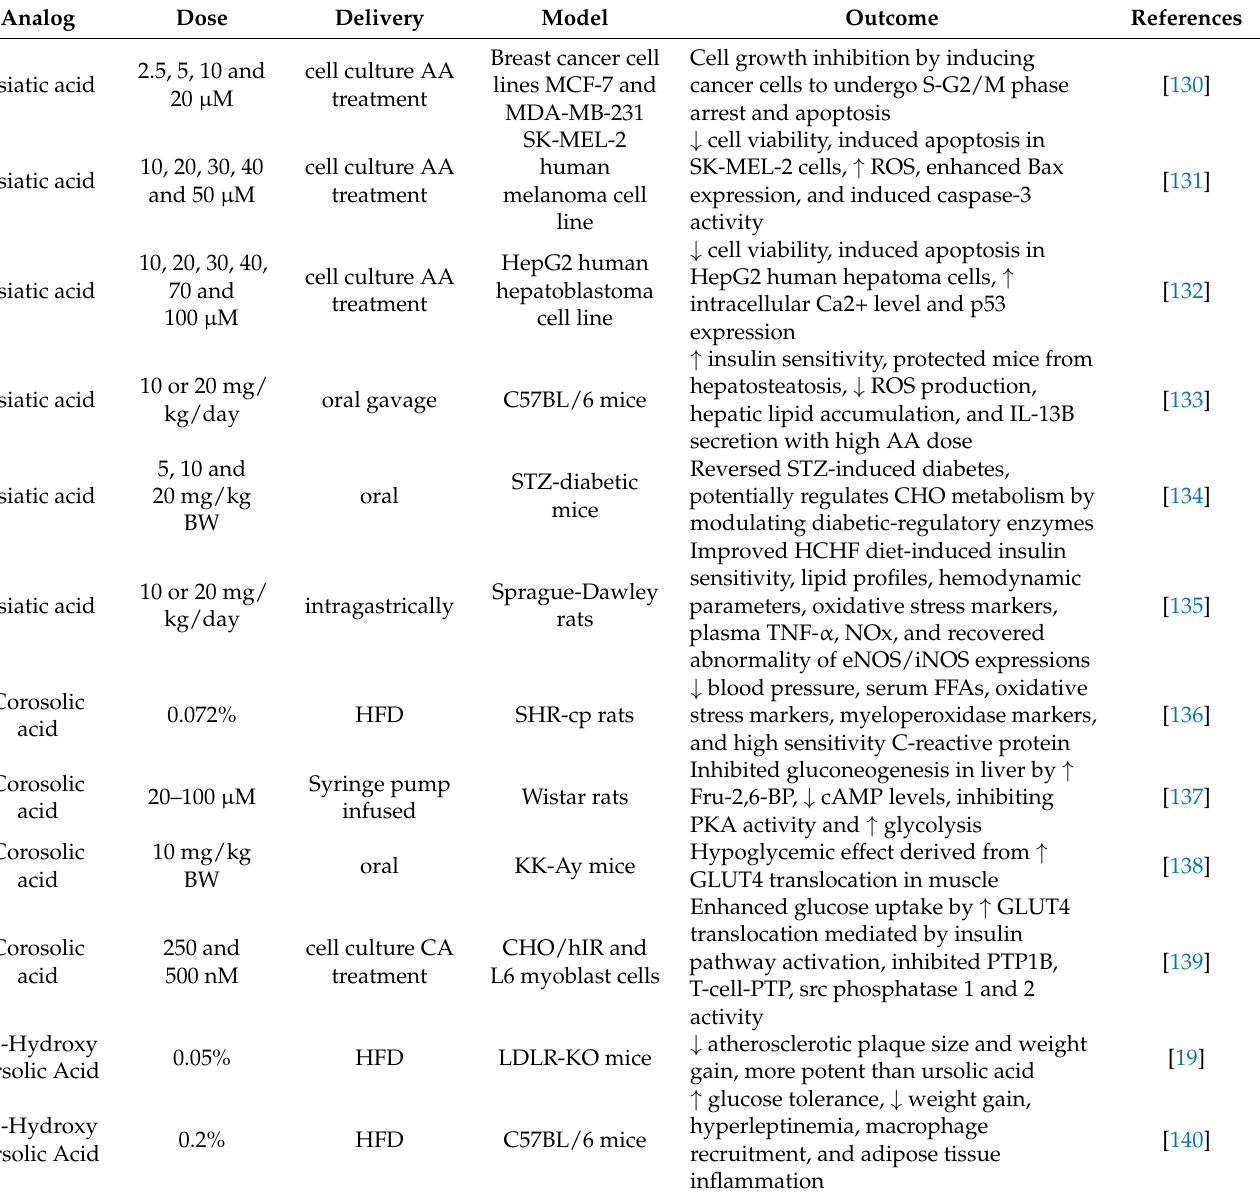
Table 3. Effects of natural UA